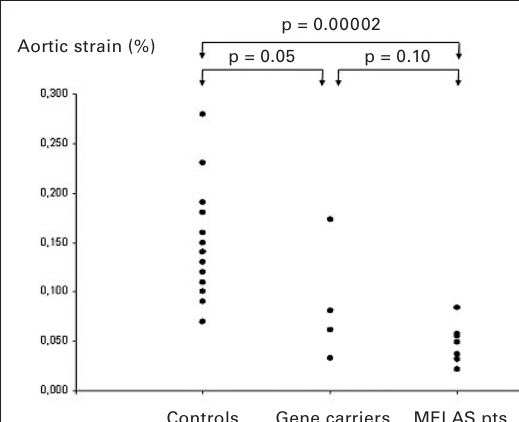
Individual aortic distensibility values of MELAS patients, gene carriers and control